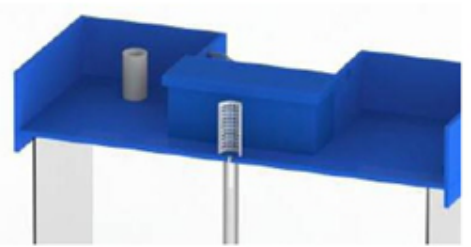
Figure 10. The fail-safe stand pipe